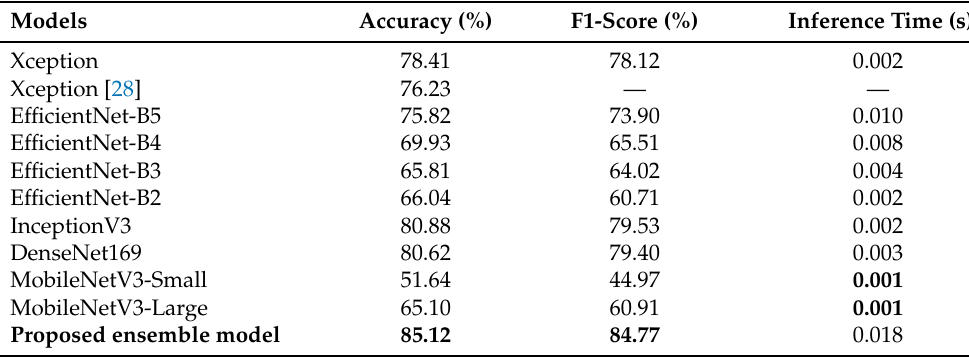
Table 5. Performance evaluation of wildfire classification